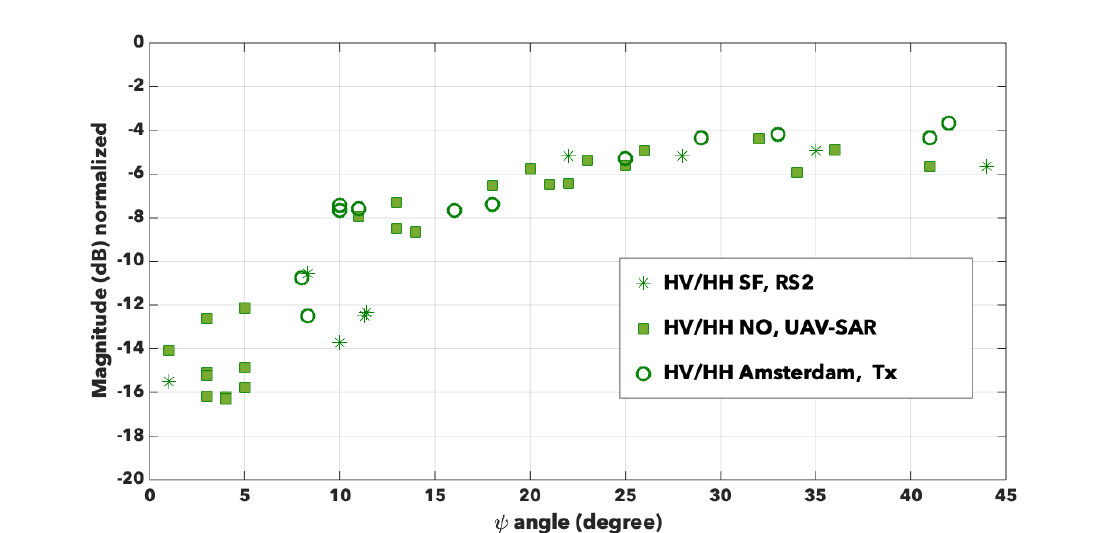
Figure 10. Variation of the ratio HV with the orientation angle for San Francisco (stars), New Orleans HH (full squares) and Amsterdam (empty